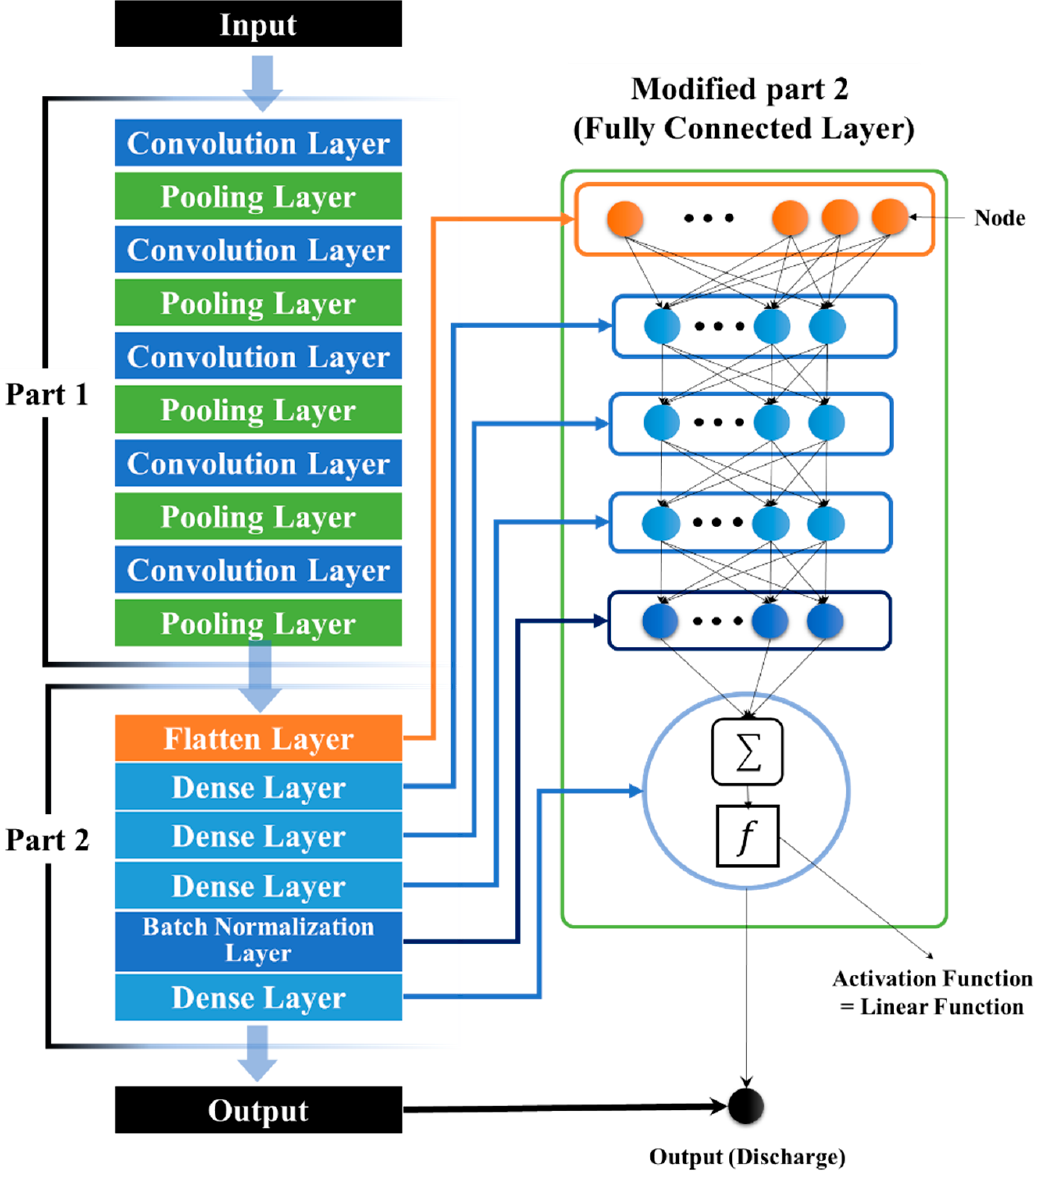
Figure 5. Improvement of CNN model for simulation of the discharge.